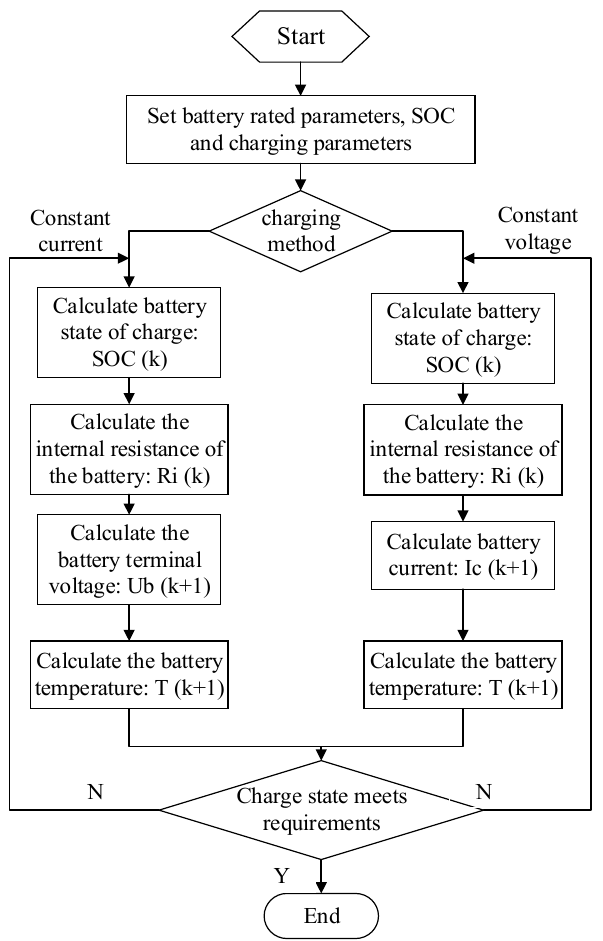
Figure 3. Flowchart of the battery model simulation charge response calculation.